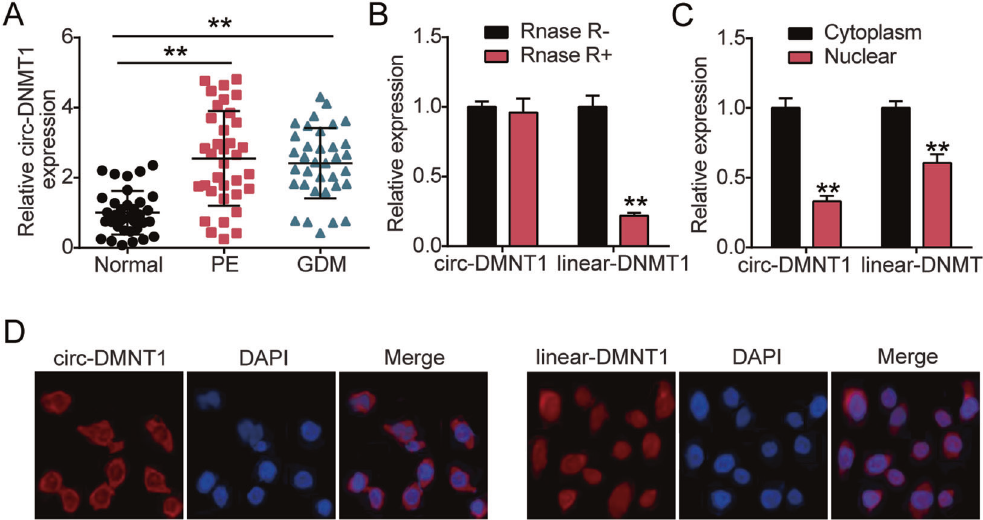
Fig. 1 circ-DMNT1 was upregulated in PE and GDM placenta and located in the cytoplasm of HTR-8/SVneo cells. A qRT-PCR analysis of circ-DMNT1 expression in PE ( N = 35) and GDM placentas ( N = 35). ** P < 0.001. B The expression of circ-DMNT1 and linear DMNT1 were detected by RT-qPCR in HTR-8/SVneo cells with or without RNase R treatment, ** P < 0.001 compared with the RNase R − group. C The nuclear and cytoplasmic qRT-PCR was carried out to verify subcellular localization of circ-DMNT1 and linear DMNT1in HTR-8/SVneo cells, ** P < 0.001 compared with the cytoplasm. D Subcellular localization of circ-DMNT1 and linear DMNT1 was determined by in situ hybridization assay. N = 3, repetition =